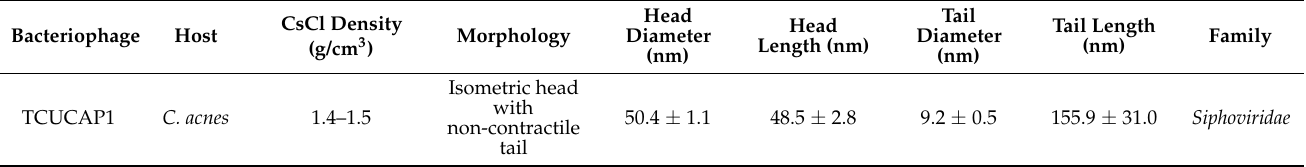
Table 1. Characterization of phage